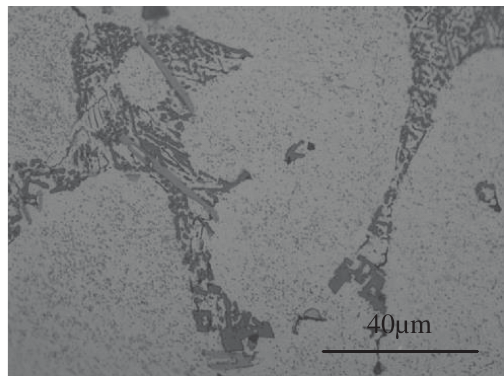
Figure 1: The microstructure of A356 BM.